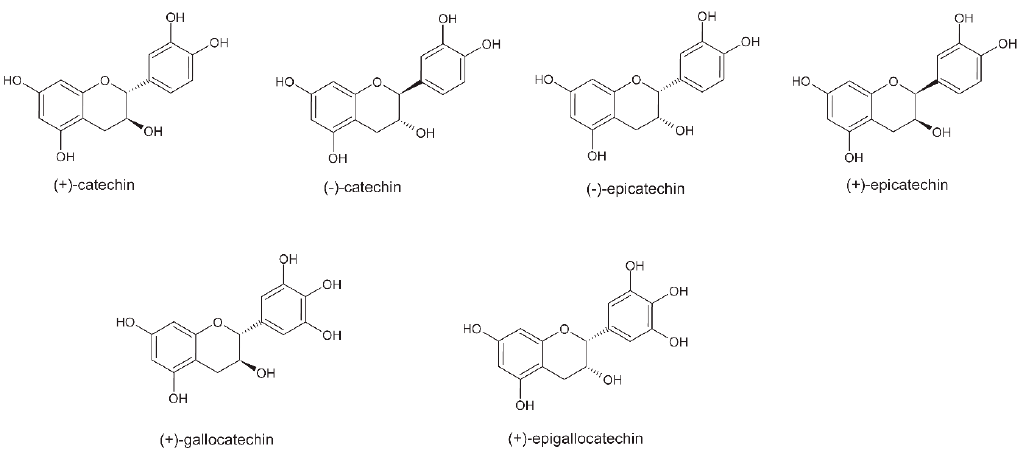
Figure 4. Structure of main flavan-3-ols present in cocoa and chocolate.